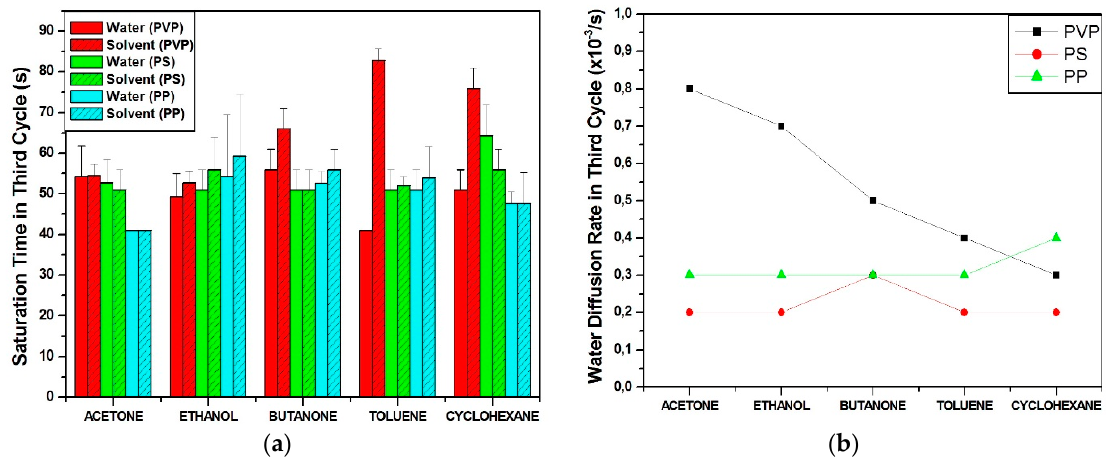
Figure 7. ( a ) Comparison of the saturation times t S in the third cycle (when sensors are exposed to water in experiment 1 and to the solvent in experiment 2) for all sensors, ( b ) Comparison of the water diffusion rate in the third cycle (Slope 𝑴 𝟐𝑾 ) of experiment 1 for all vQRS.